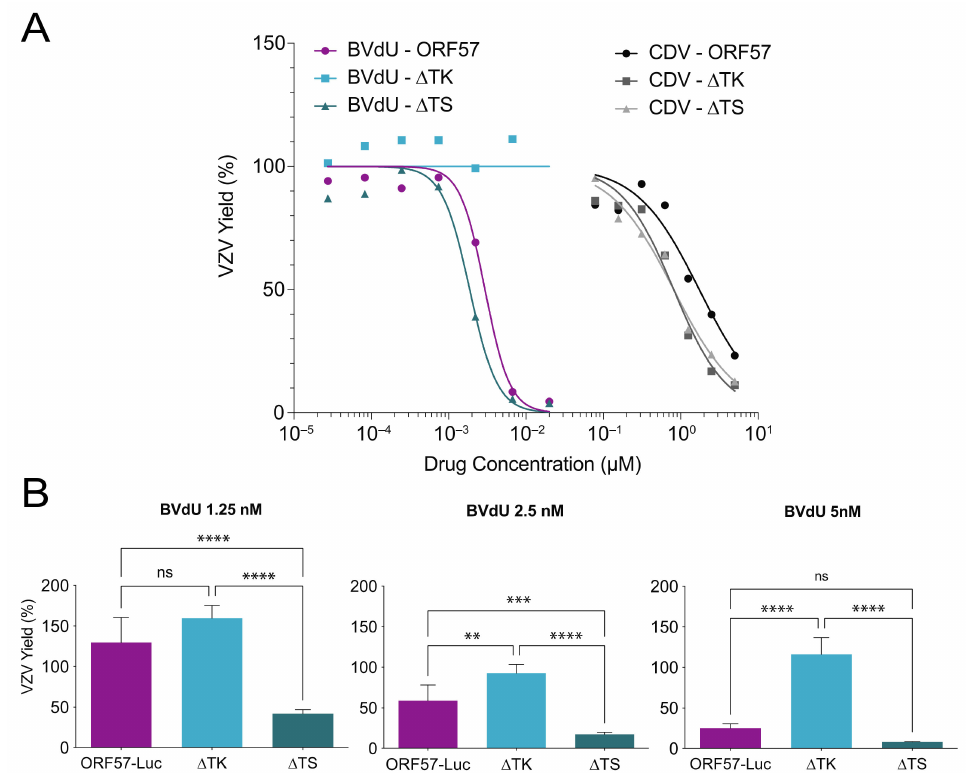
Figure 5. Loss of VZV TK and TS affect virus sensitivity to select antivirals in cell culture. Cell-free VZV was added to ARPE-19 monolayers at 37 ◦ C and compounds were added at 2 h postinoculation (HPI). Antiviral compounds remained in culture medium until VZV yield was measured on DPI 3. Infected cells were treated with cidofovir (CDV) and brivudine (BVdU) ( A ) in a range of concen- trations, or ( B ) at specific concentrations of BVdU (1.25, 2.5, or 5 nM). VZV yield was calculated as the average Total Flux of treated wells divided by the average Total Flux of untreated wells. ( A ) Each point represents the mean Total Flux with the best fit line. ( B ) Each bar represents the mean + SD. Asterisks indicate significance between VZV viruses for each treatment condition (ns = no significance; ** p < 0.01; *** p < 0.001; **** p < 0.0001). p < 0.05; one-way ANOVA; Tukey post hoc test. n = 3 ( A ) to 6 ( B ) biological